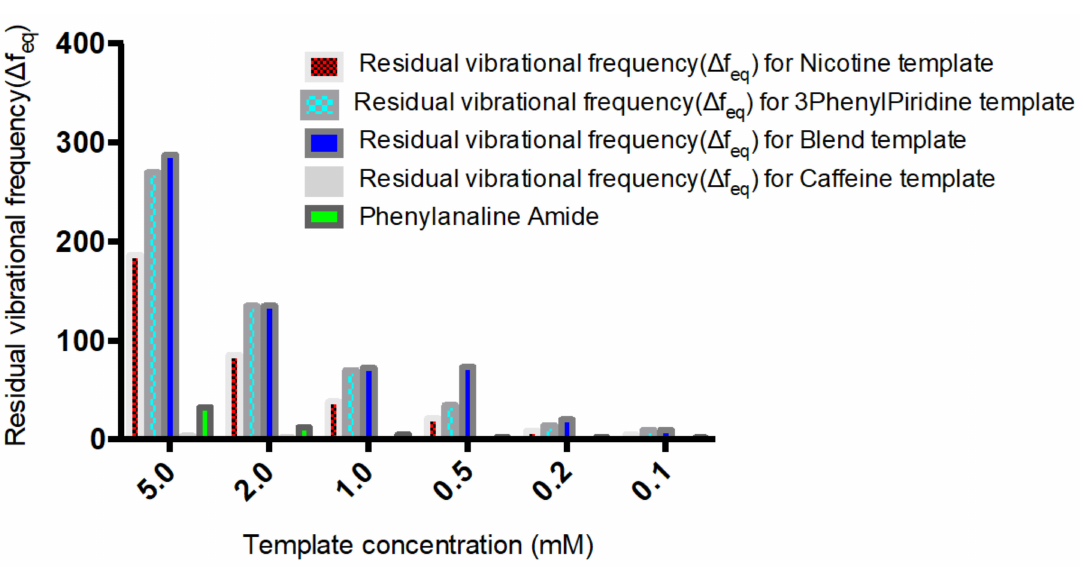
Figure 5. Sensitivity and selectivity of Nicotine, 3-Phenylpiridine, Nicotine-3-Phenylpiridine and Caffeine chitosan-based MIP.